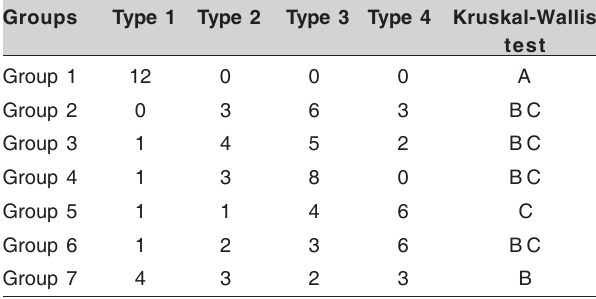
Fig. 2. Mean fracture resistance (in N) for each group. Table 2. Failure